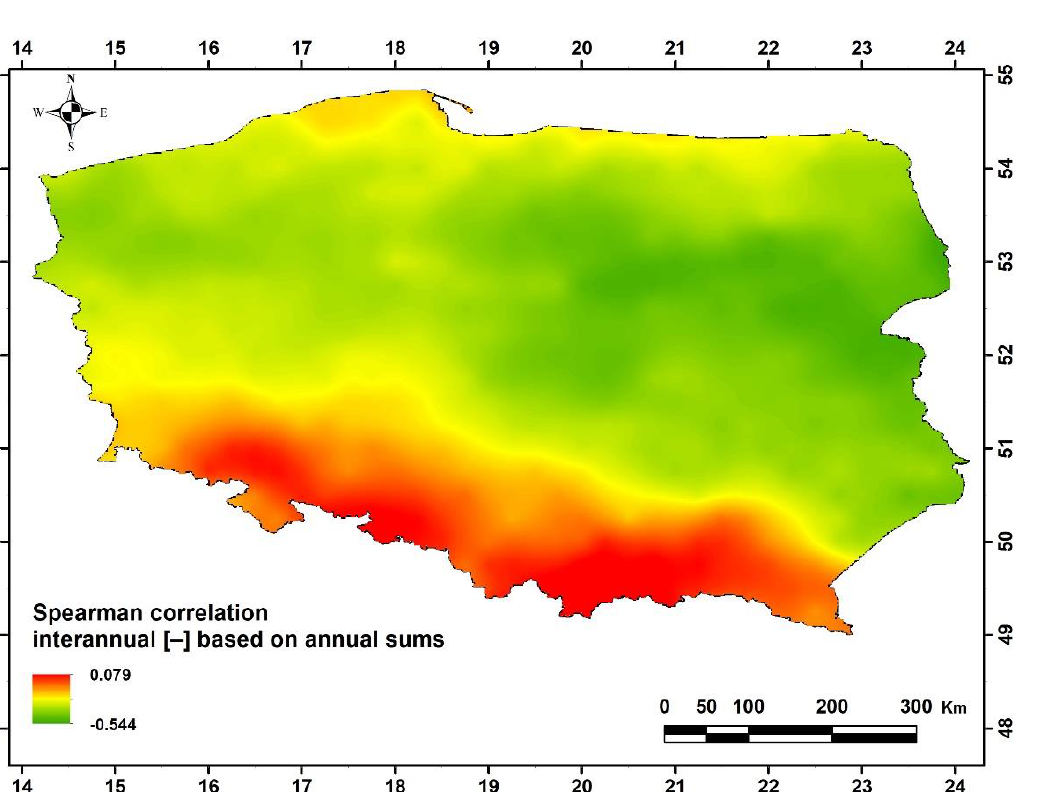
Figure 7. Inter-annual relationship between solar and wind resources for all grid points within the borders of Poland, 1980 – 2019. 3.2. Temporal Complementarity of Solar and Wind Resources